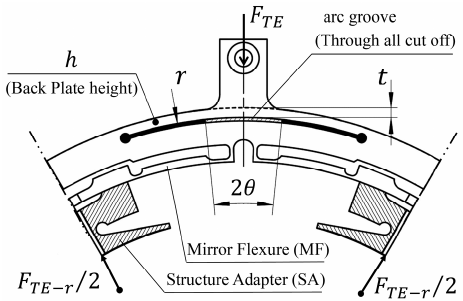
Figure 11. Parameters of the proposed AEIF.